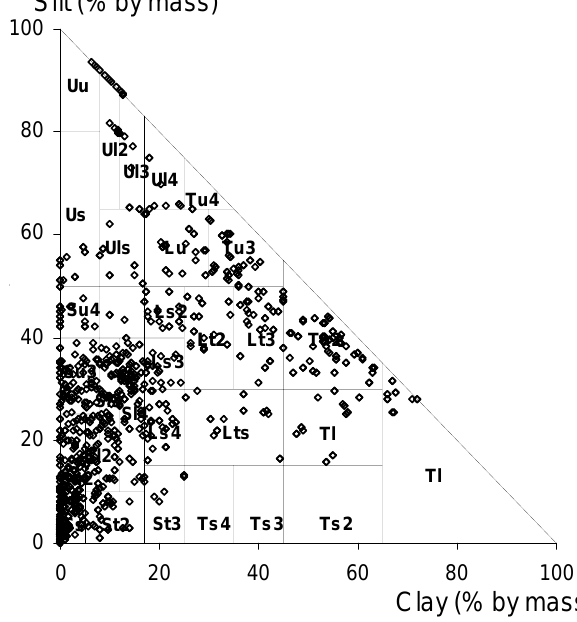
Figure 1. Distribution of texture classes according to German classification (Arbeitsgruppe Boden, KA4, 1994) of the investigated soils. Warning: There is a mismatch between the German PSD system and the internationally frequently used FAO/USDA system.